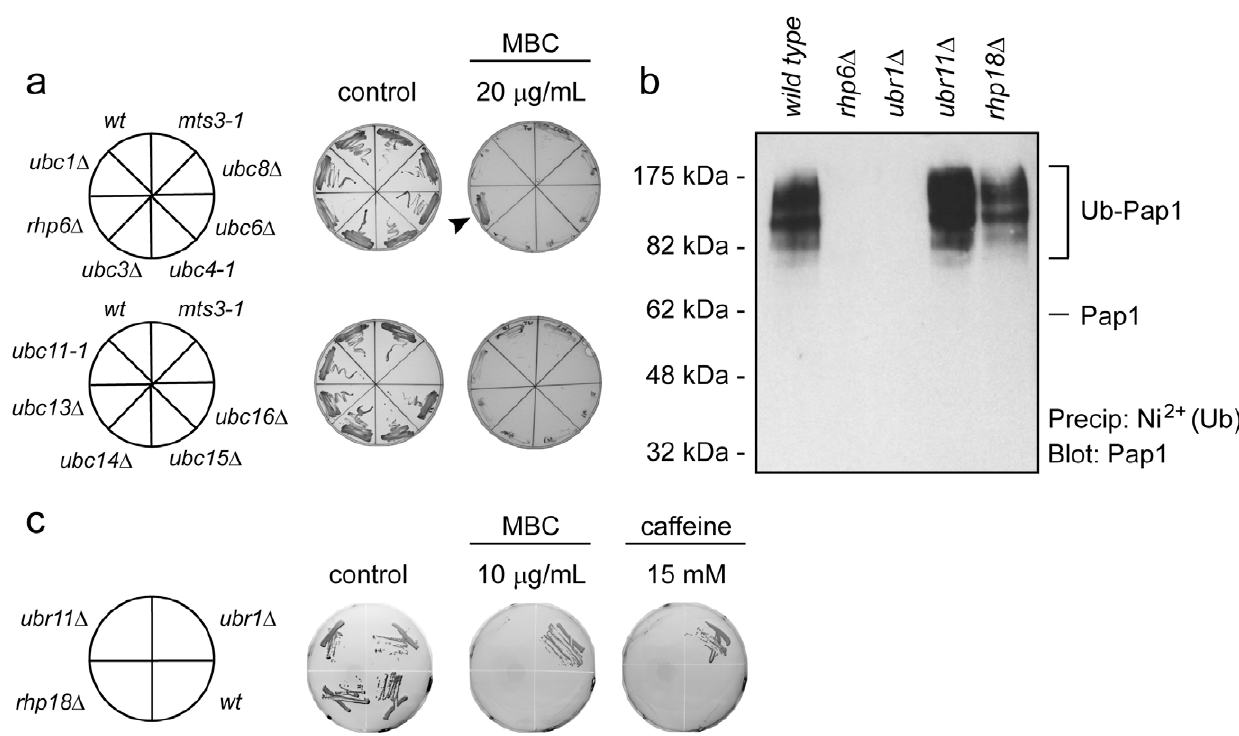
Figure 5. Pap1 is ubiquitylated by Rhp6/Ubc2 and Ubr1. (a) To identify which E2 ubiquitin conjugating enzyme is responsible for ubiquitylating Pap1, the indicated E2 null mutants were streaked onto solid medium containing MBC and grown for 48 hours at room temperature. Since the rhp6 D cells grow in the presence of MBC (arrowhead) it was a candidate E2 in Pap1 ubiquitylation. (b) To identify the E2 and E3 enzymes responsible for ubiquitylating Pap1, the indicated strains were transformed to express 6His-tagged ubiquitin. The 6His-tagged ubiquitin was then precipitated using Ni 2 + agarose under denaturing conditions and analyzed by Western blotting using antibodies to Pap1. Ubiquitylated species of Pap1 were detected in wild type, ubr11 D and rhp18 D cells, but not in cells lacking the E2 ubiquitin conjugating enzyme Rhp6 and in cells lacking the E3 ubiquitin-protein ligase Ubr1. (c) The indicated yeast strains (left panel) were streaked onto solid medium containing MBC or caffeine at the shown concentrations and incubated for 48 hours at room temperature. On the control medium lacking drugs all the strains grew. In the presence of drugs the growth of wild type cells was compromised, while the ubr1 D mutant displayed resistance.